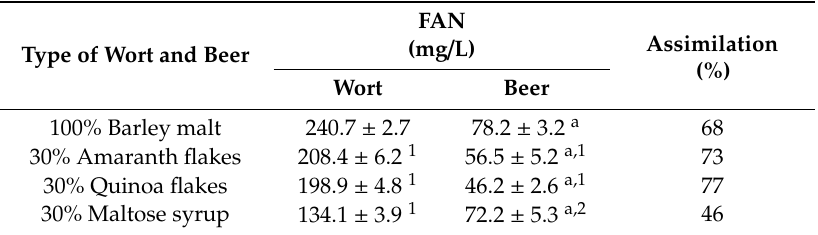
Table 2. The concentration of the free amino nitrogen in worts and